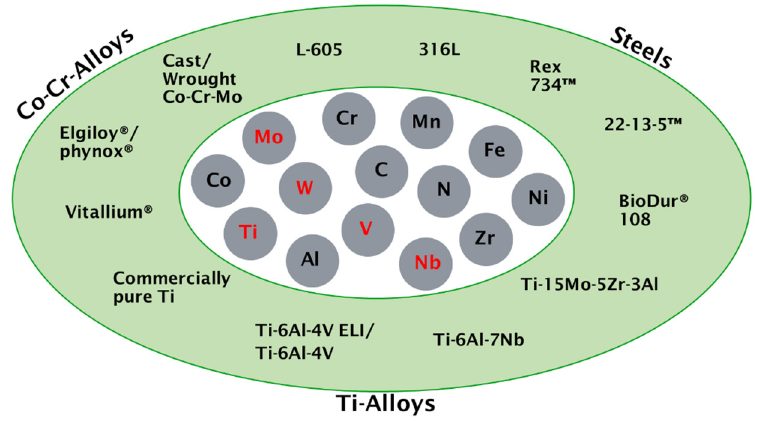
Figure 1. Schematic representation of state-of-the-art biomaterials data from [9–13] and the corre- sponding chemical elements; refractory metals of potential interest are highlighted.